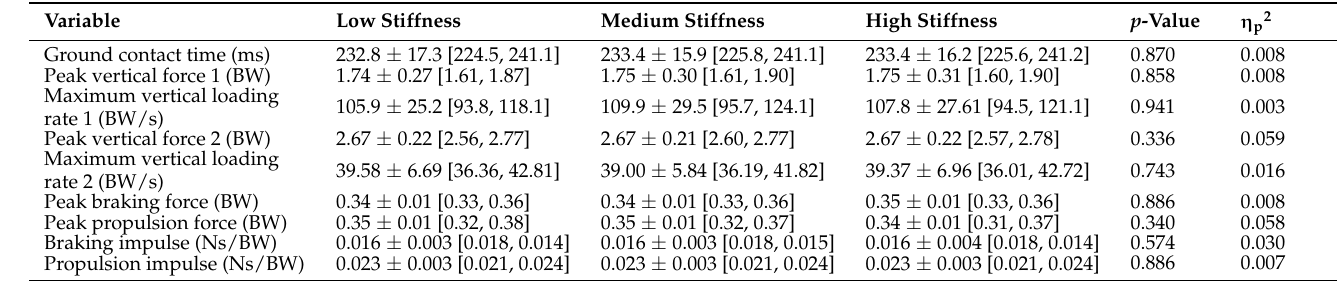
Figure 5. Averaged force-time curves displayed the vertical and anterior-posterior GRF. Grey, pink, and green curves separately indicate the low stiffness, medium stiffness, and high stiffness conditions. The dashed line reflects the anterior-posterior force crossed zero. Table 3. GRF ‐ related variables (Mean ± SD [95% confidence interval]) of experimental shoes.